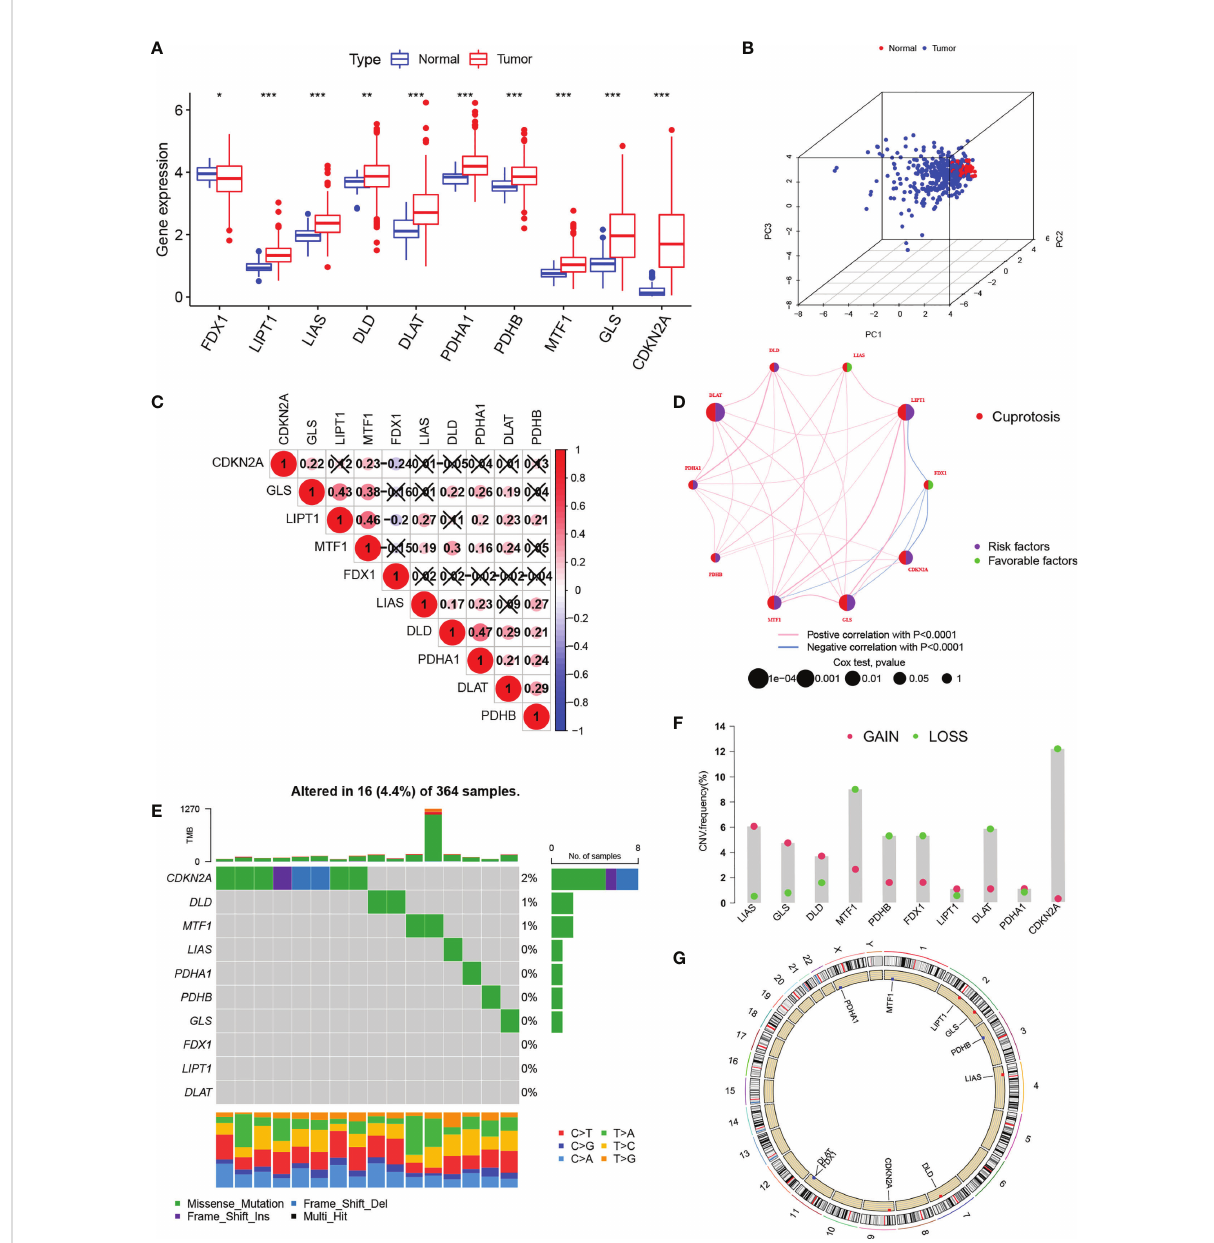
FIGURE 1 Expression of cuproptosis-regulatory genes in HCC. (A) Comparison of expression between normal and tumor tissues (B) PCA of the expression of the 10 genes. (C) Spearman correlations between genes. The color blue represents negative regulation; the color red represents positive regulation. (D) Comprehensive network map combining cuproptosis regulator interactions and prognosis. (E) Mutation frequencies of the 10 regulatory genes in 364 HCC s specimens. (F) CNV values for cuproptosis regulators in HCC specimens. (G) Chromosomal locations of CNV alterations in cuproptosis regulators. *P < 0.05; **P < 0.01; ***P < 0.001. HCC, hepatocellular carcinoma; PCA, principal component analysis; CNV, copy number